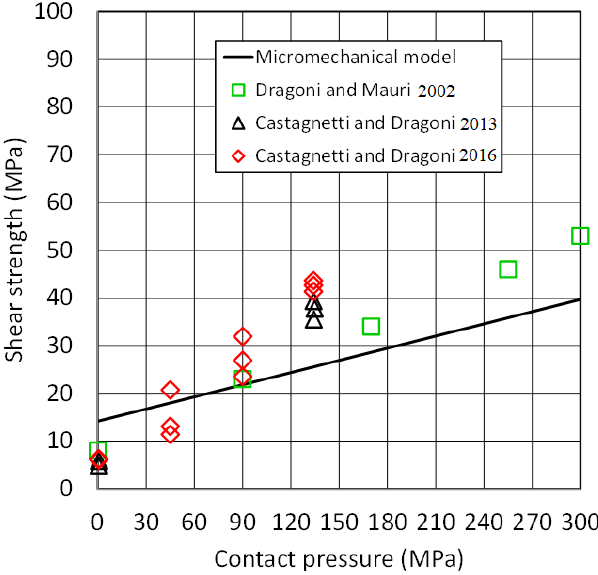
Figure 7. Comparison between the computational model prediction and experimental data from the literature [2,40,42] for the Loctite 243 adhesive.